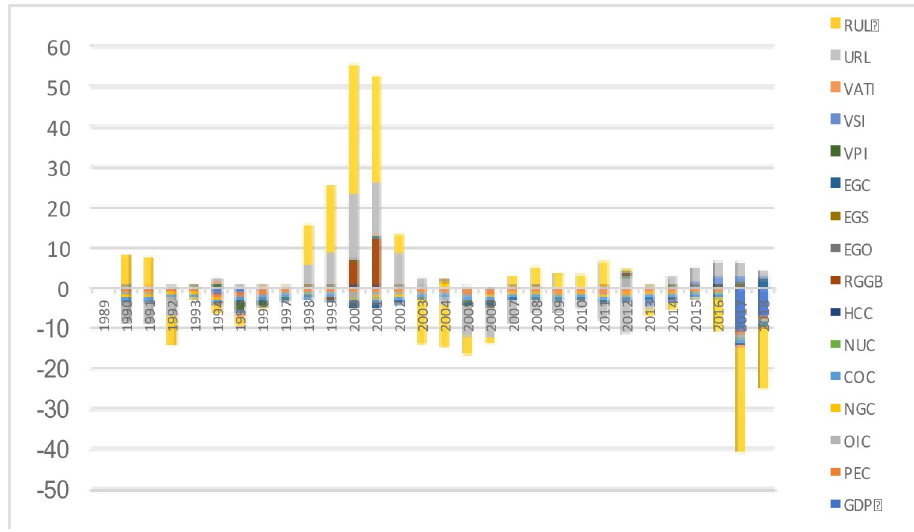
Fig 4. Beta decoupling of